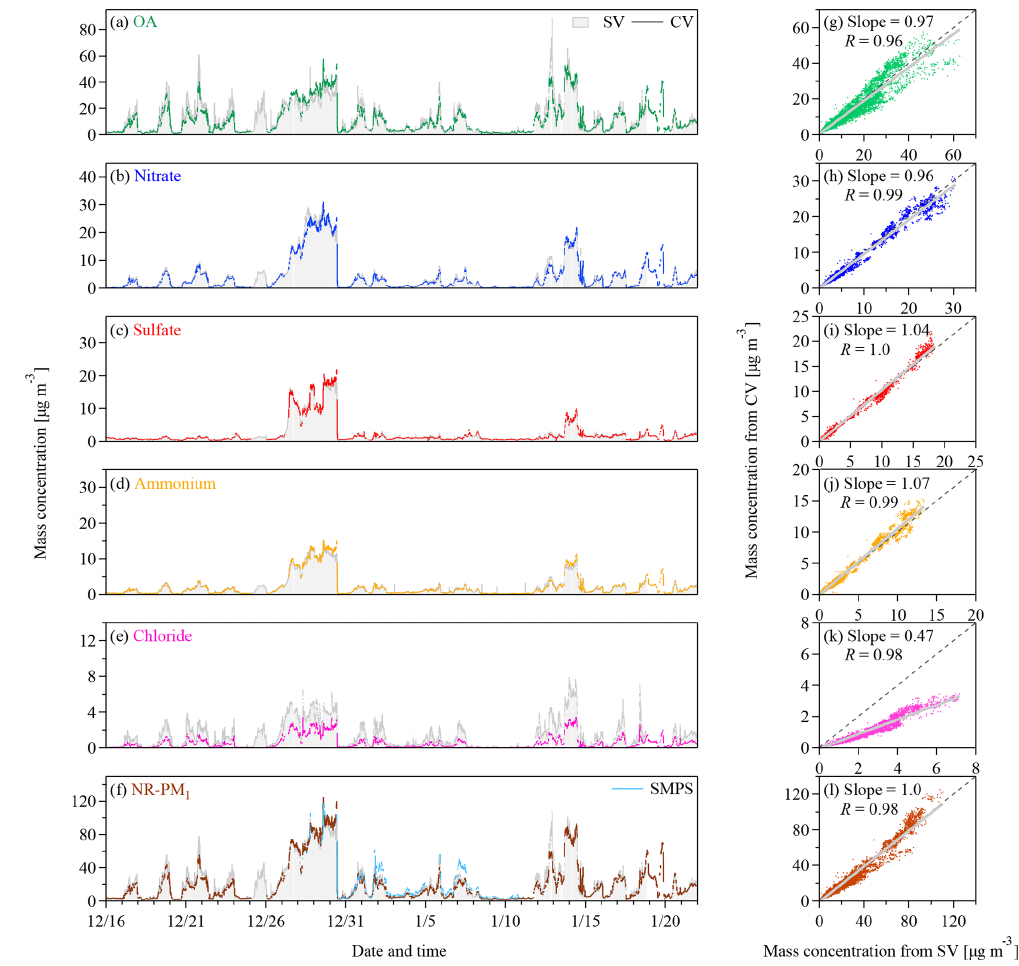
Figure 3. (a–f) Time series and (g–l) scatter plots of the mass concentrations of OA, nitrate, sulfate, ammonium, chloride, and the sum of them (i.e., total NR-PM 1 ) measured by the CV TOF-ACSM and the SV AMS. Panel (f) also shows the mass concentrations of PM 1 derived from the SMPS measurements for an assumption of spherical particles with an effective density of 1350kgm − 3 . The grey lines in the scatter plots represent the orthogonal distance regressions with intercepts. The slopes and the correlation coefficients (Pearson’s R ) are shown in the